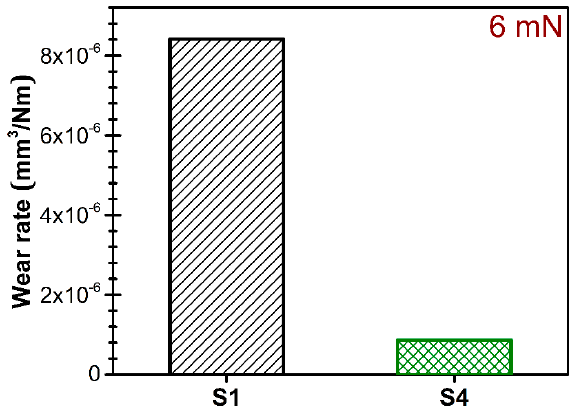
Figure 11. Graphical representation of the wear rate values of the S1 and S4 films obtained by reciprocating sliding tests carried out at a force of 6 mN for 400 cycles.